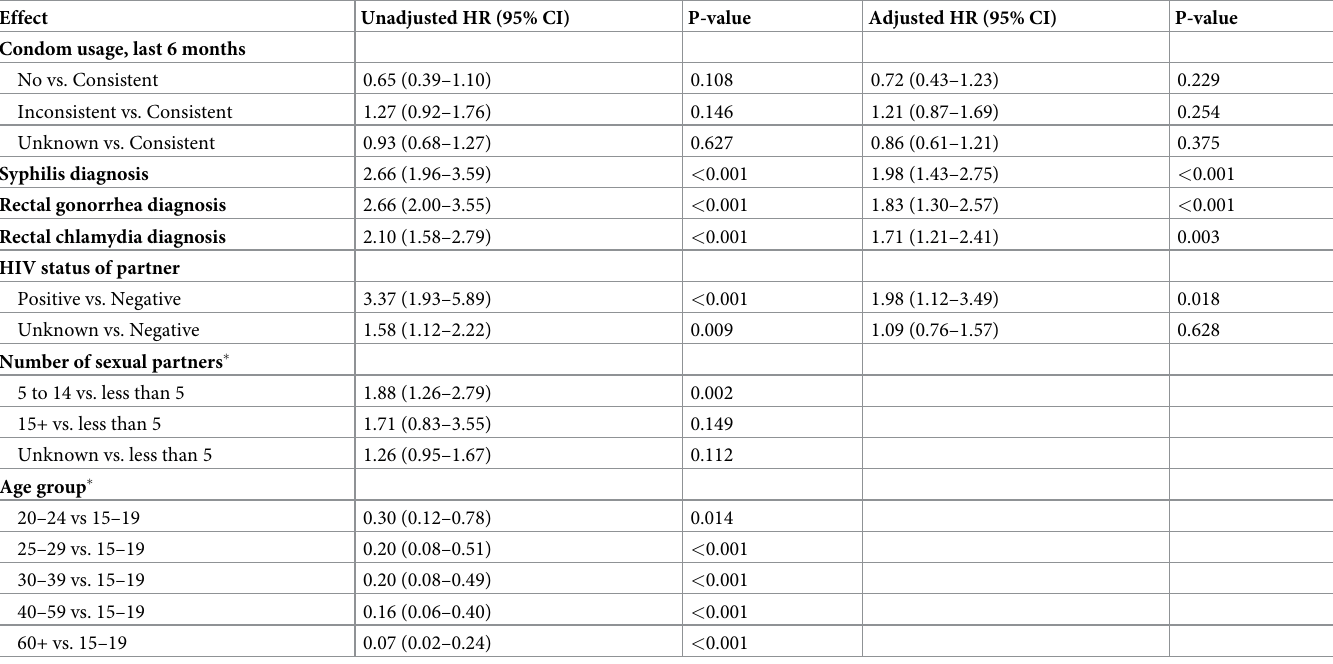
Table 4. Unadjusted and adjusted hazard ratios of predictors of HIV seroconversion risk from 2004 to 2017 (N =